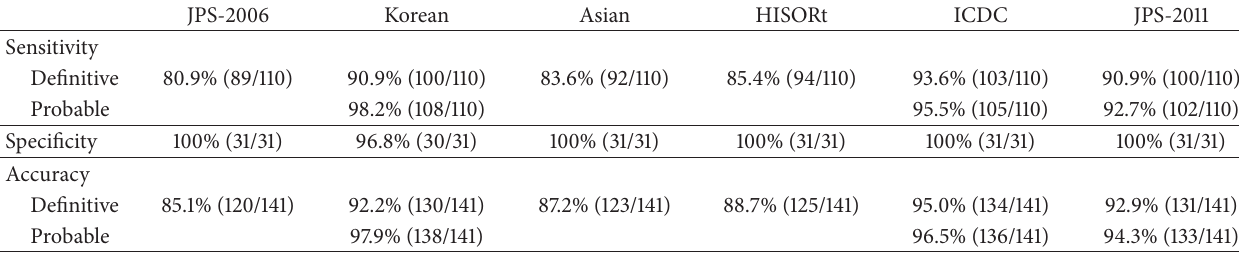
Table 2: Sensitivity, specificity, and accuracy of each diagnostic criteria system for AIP.